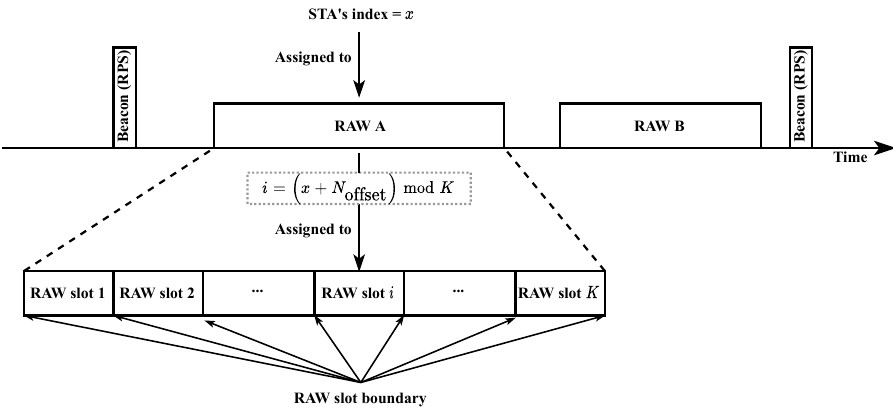
Figure 1. Schematic representation of the RAW